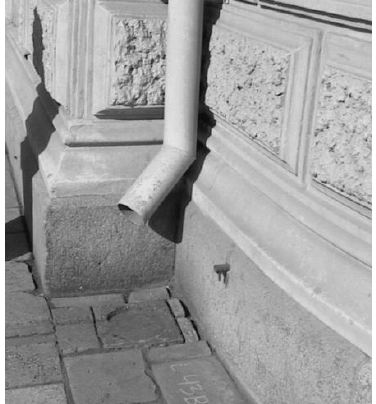
Figure 4. An example of a levelling benchmark (photo: Veikko